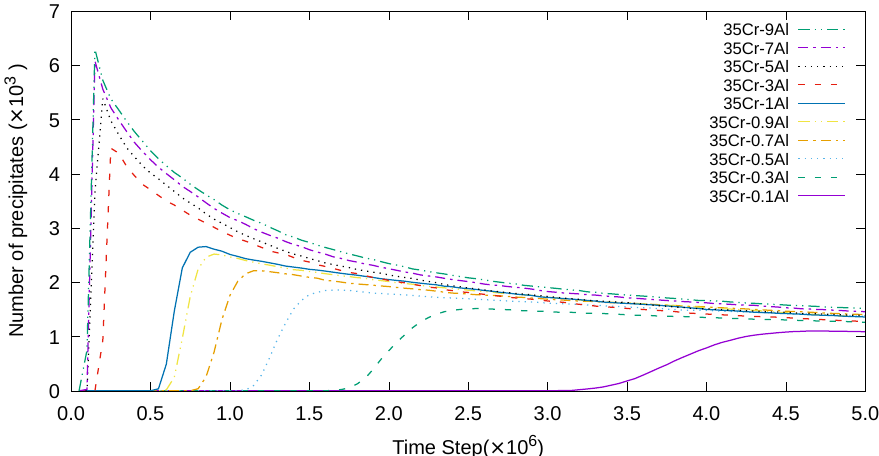
Figure 5. Average α (cid:48) precipitate area of the 2D simulation when the average Cr concentration was 35% at various average Al concentrations.